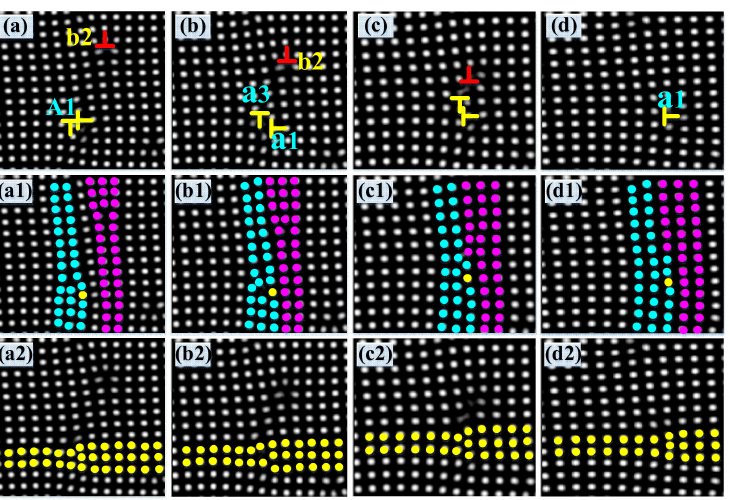
Figure 6. Schematic diagram of the type I semi-annihilation of A1 and b2 in Figure 3c. ( a – d ) corresponding time steps are t * = 24,700; t * = 24,800; t * = 24,900; and t * = 25,000. ( a1 – d1 ) is a schematic diagram of the atomic structure in the x direction. ( a2 – d2 ) is the atomic structure in the y direction.